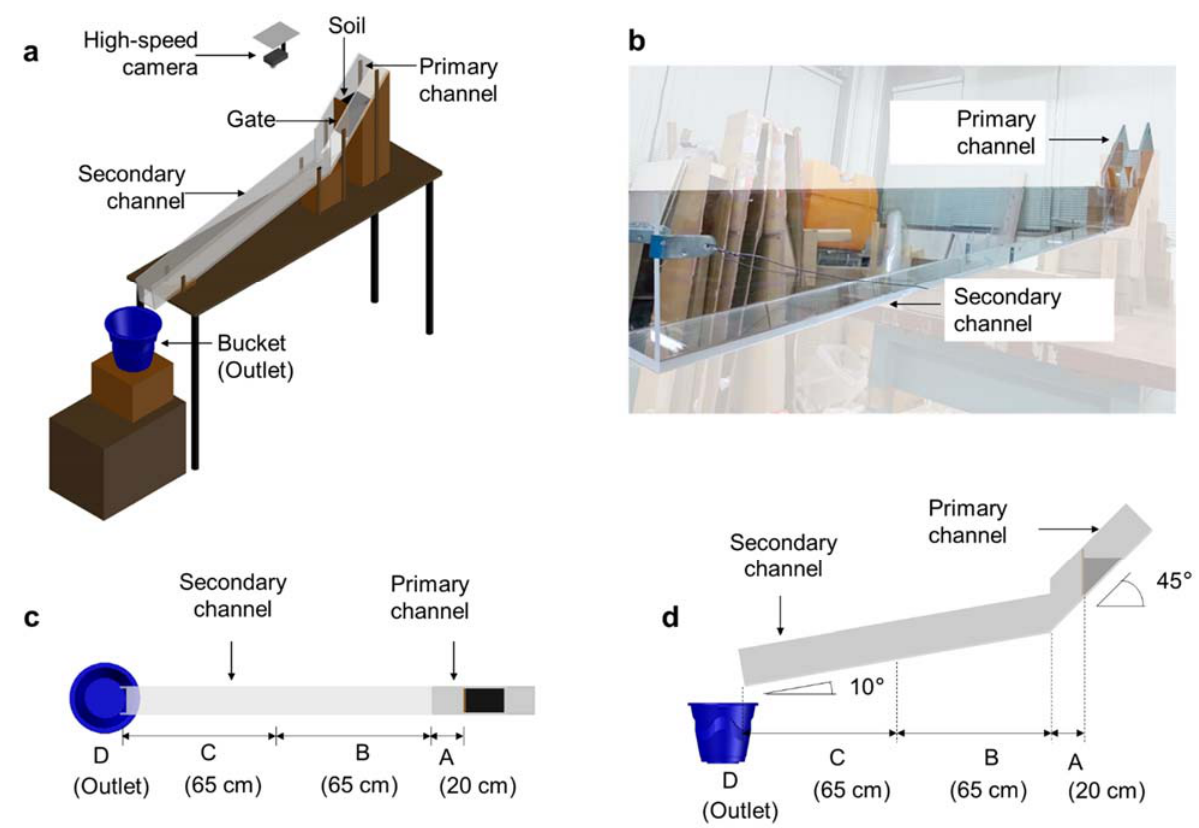
Figure 3. ( a ) Schematic illustration of the experimental setting; ( b ) Flume apparatus; ( c ) Flume segments ( top ); ( d ) Flume segments ( side ).